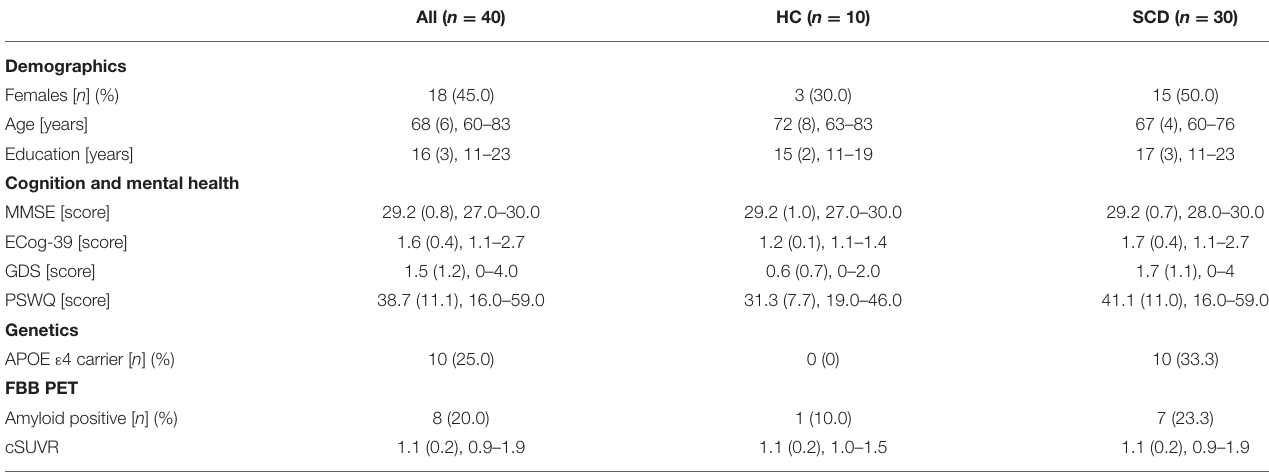
TABLE 1 | Characteristics of study participants.